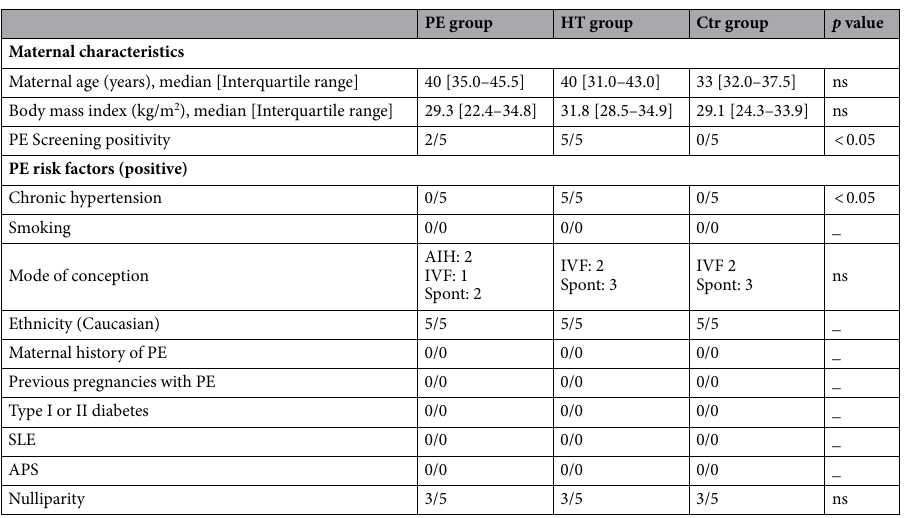
Table 1. Clinical characteristics of patients for each cohort (n = 5 for each group), including parameters used for PE screening according to Fetal Medicine Foundation London 44 . AIH artificial insemination by husband, APS antiphospholipid syndrome; Ctr control, IVF in vitro fertilization, HT hypertension, PE preeclampsia, SLE systemic lupus erythematosus; Spont spontaneous conception.